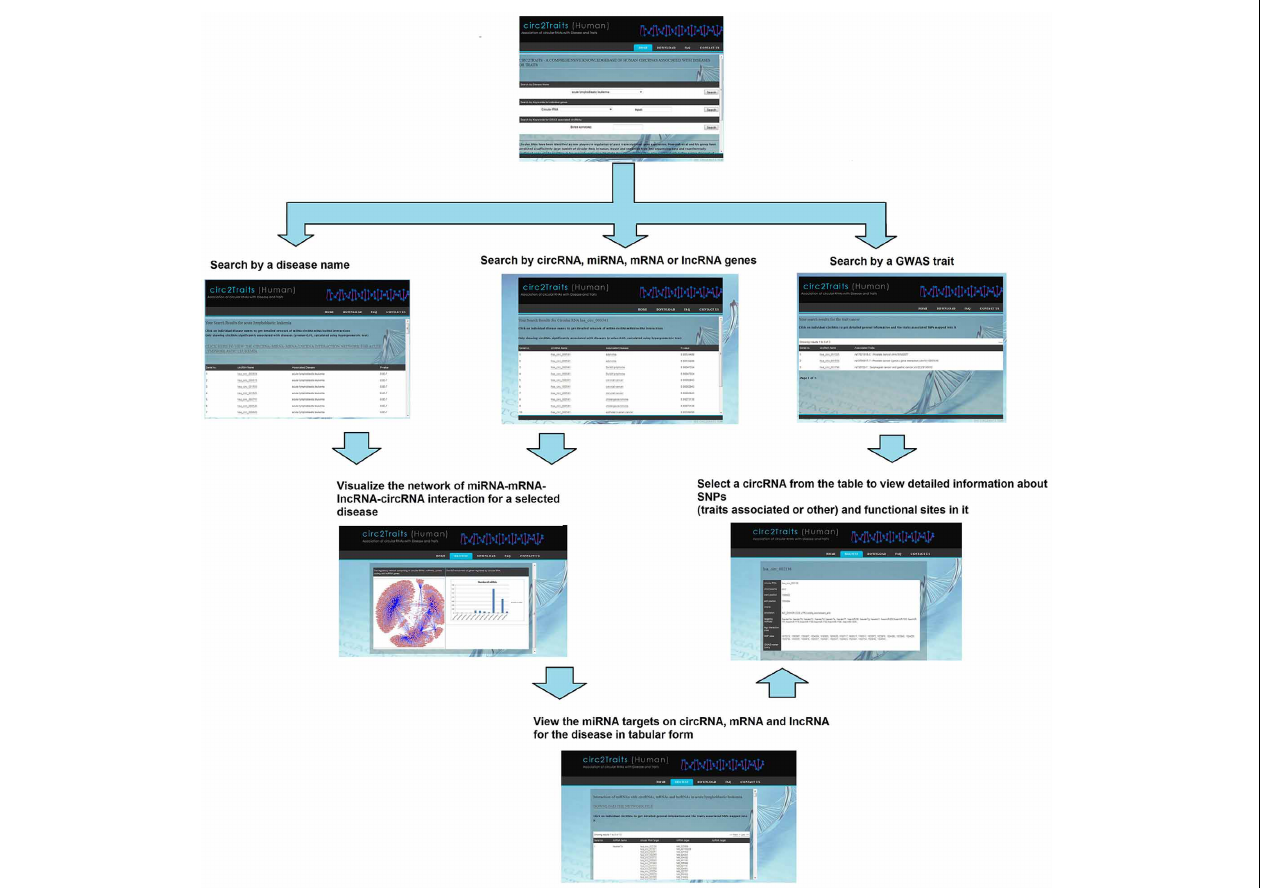
FIGURE 4 | A flow diagram showing the usage of circ2Traits database. In the first step, users can search by either disease name, or circRNA/miRNA/mRNA/lncRNA identifier, or traits by keyword. The results page will show the circRNAs/miRNAs/mRNAs/lncRNAs potentially associated